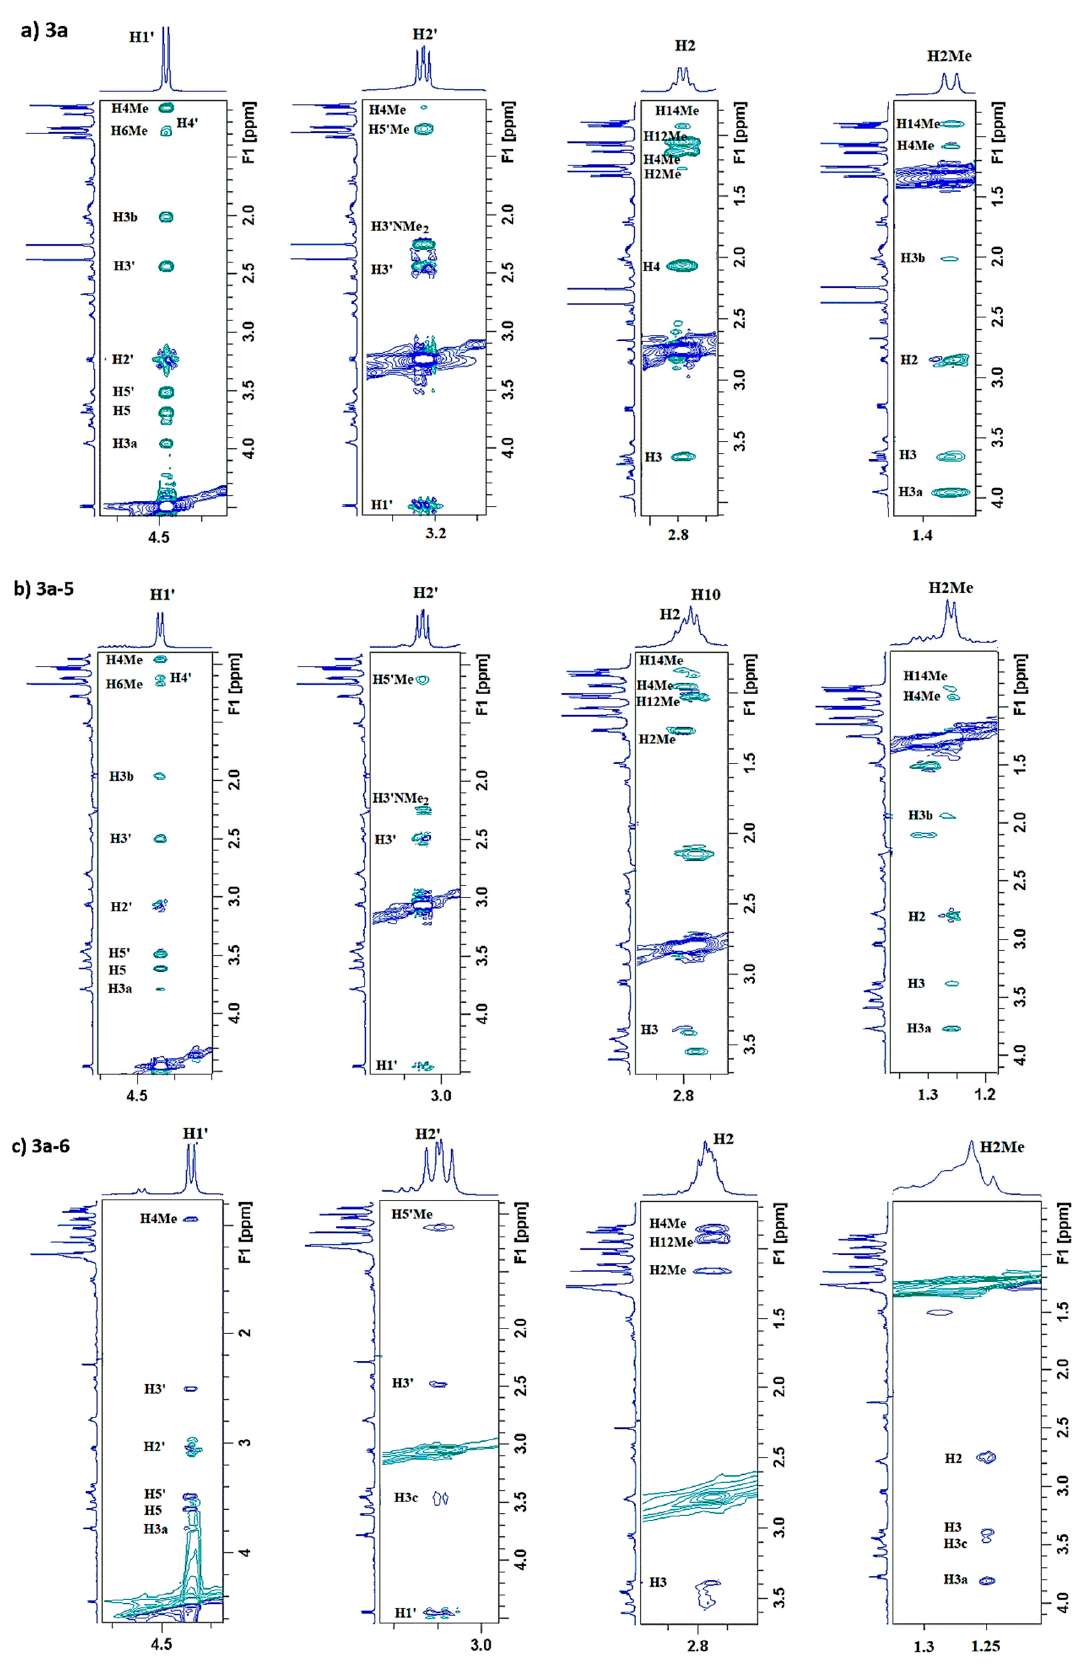
Figure 6. Narrow regions of the NOESY spectra of ( a ) 3a , ( b ) 3a-5 and ( c ) 3a-6 for atoms H-1 ′ , H-2 ′ , H-2 and H-2Me.